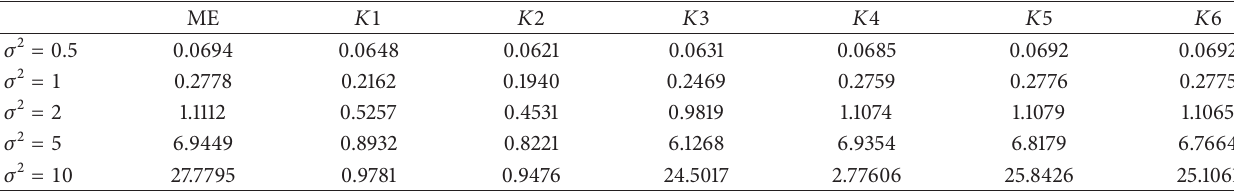
Table 17: Estimated MSE with 𝑛 = 50 , 𝑝 = 8 , and 𝛾 = 0.75 .